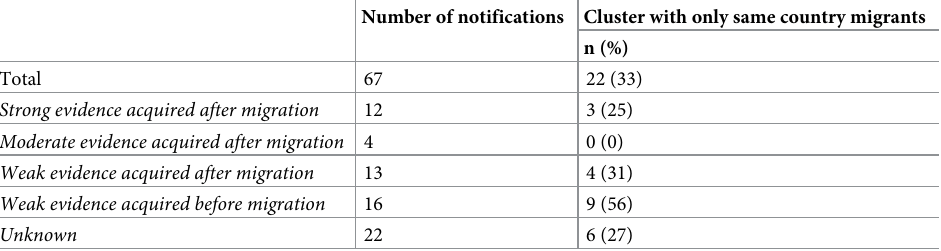
Table 3. Single country of origin clustering among 67 heterosexual migrants with new HIV notification 2005– 2014 who are members of phylogenetic clusters, by timing of HIV acquisition relative to